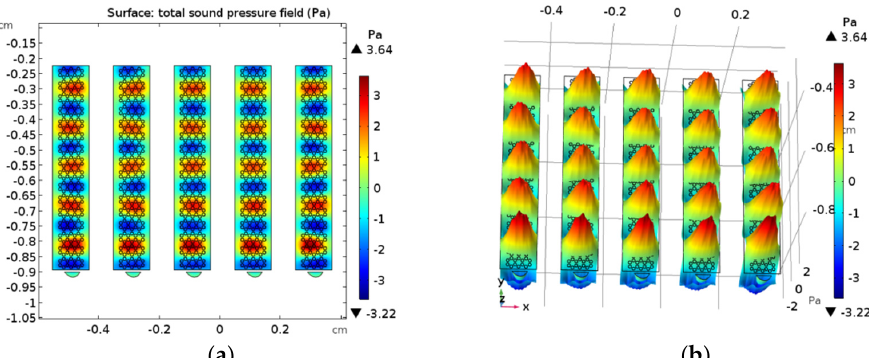
Figure 3. Transmission effect: ( a ) two-dimensional sound field distribution; ( b ) three-dimensional height expression.